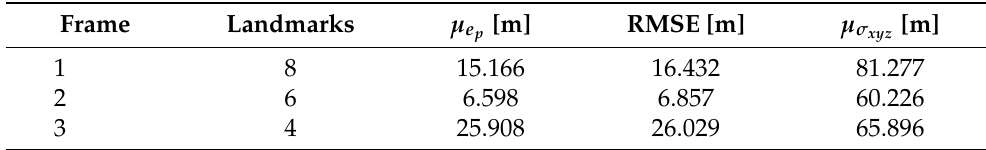
Table 12. UAVision footage